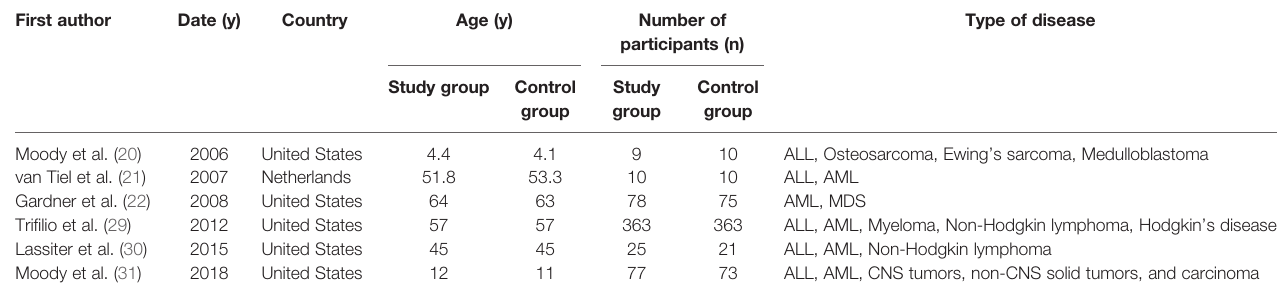
TABLE 1 | The baseline characteristics of all included